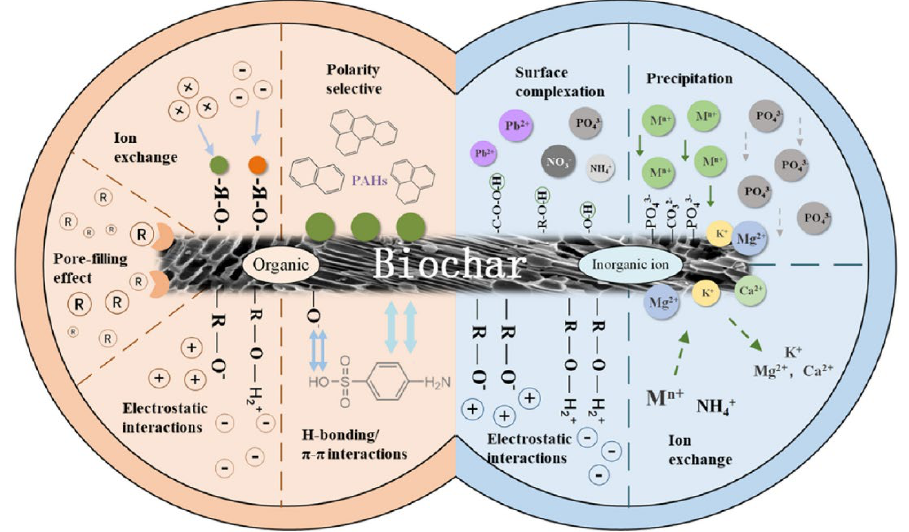
Figure 1. Adsorption mechanism of microalgae-based biochar [77].